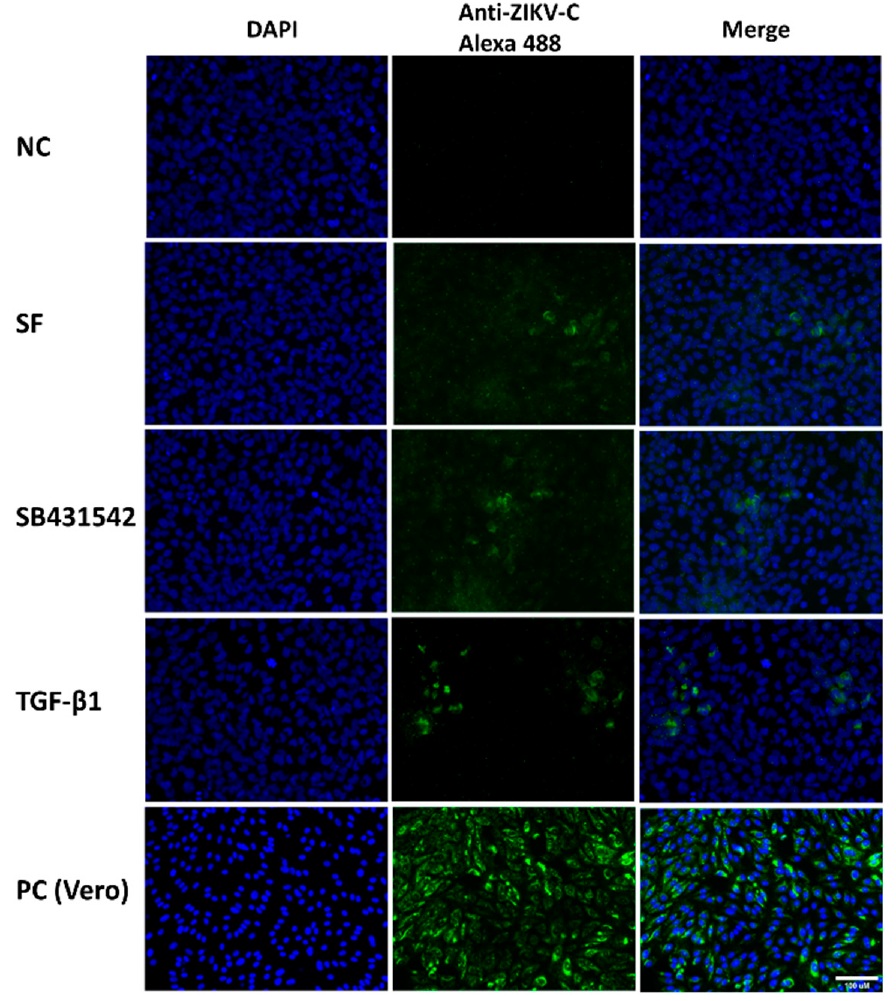
Figure 2. Representative microscopy images of Swan.71 cells infected with ZIKV at 48 hpi. The cells were fixed and labeled with a rabbit polyclonal anti-ZIKV viral capsid antibody followed by an Alexa 488-conjugated goat anti-rabbit IgG (H + L) secondary antibody (green). Nuclei were stained with DAPI (blue). ZIKV-infected Vero cells were used as positive controls (PC). Trophoblast cells that were mock infected, incubated with heat-inactivated ZIKV, or stained with rabbit serum were used as negative controls (NC). Images are representative of 3 independent experiments. SF, Swan.71 cells cultured in the serum-free medium; SB431542, an inhibitor of TGF- β 1/Smad pathway; ZIKV-C, Zika virus capsid. Scale bar: 100 µ M.